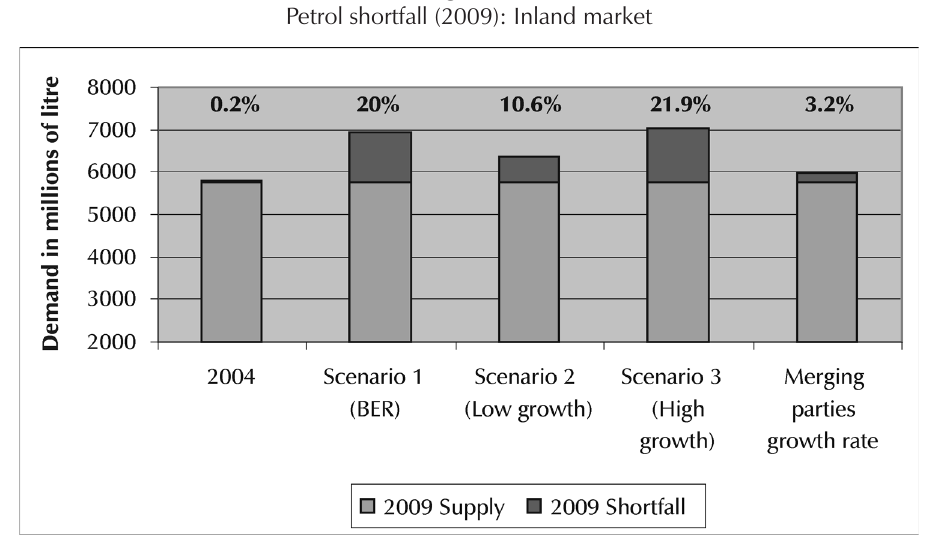
Petrol shortfall (2009): Inland